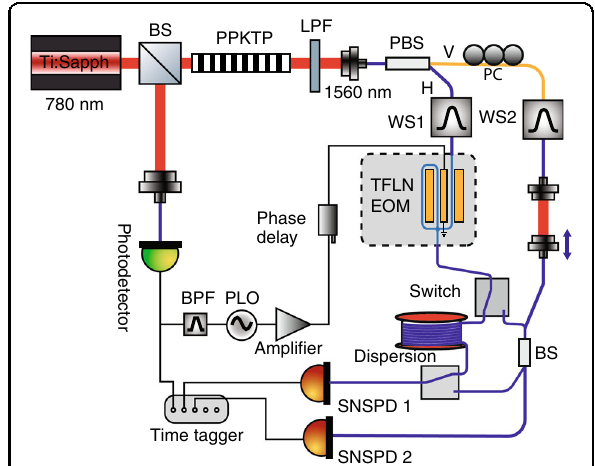
Fig. 2 Experimental set-up. Orthogonally polarized photon pairs were generated by pumping a type-II phase-matched periodically poled potassium titanyl phosphate (PPKTP) crystal with a mode-locked Ti:sapphire laser. After being separated by a fi ber polarization beam splitter (PBS), the signal photons (horizontally polarized, H) went through a double-pass TFLN modulator (EOM) with V π as low as 2.3 – 2.8 V in 10 – 40 GHz range. The output either passed through a 20 km fi ber (labeled Dispersion) followed by superconducting nanowire single-photon detectors (SNSPDs) for dispersion-based spectrum measurement or a 50:50 beam splitter (BS) for quantum interference with the idler photon (vertically polarized, V), which passed through a polarization controller (PC) and a tunable delay. The RF drive of the modulator was phase-locked to the pump laser with a tunable phase delay. Waveshapers (WS) were used to apply spectral fi ltering or spectral phase; LPF long-pass fi lter, BFP bandpass fi lter,